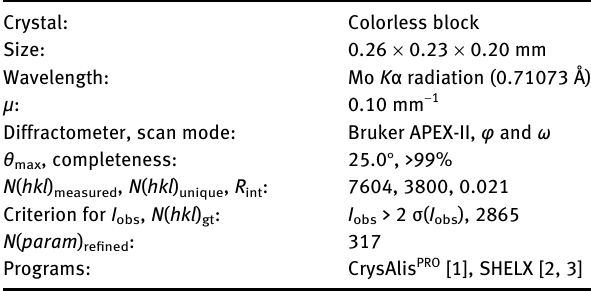
Table  : Data collection and